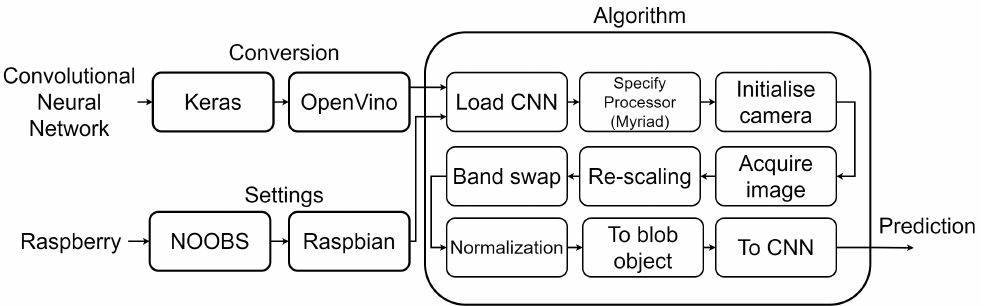
Figure 9. Block diagram for the implementation on Raspberry and Movidius stick. OpenVINO Library